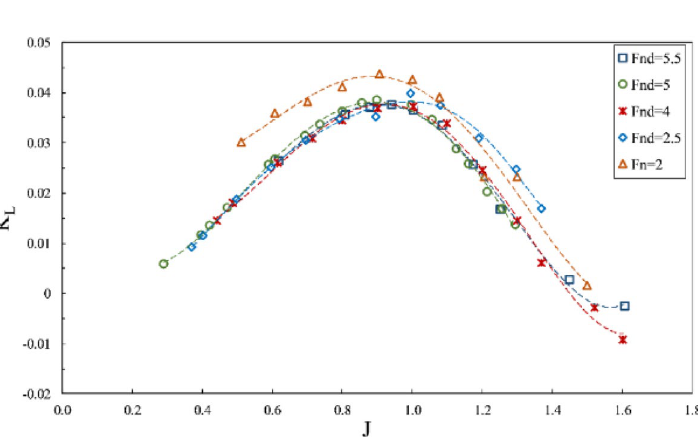
Figure 14. Lift force coefficient in propeller direction in different Froude numbers ( I = 0.4, α = 3 ◦ ).